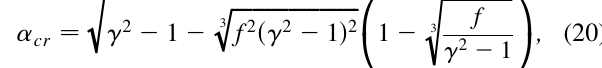
is met. At this point the bifurcation the condition f ¼ f cr resulting in the confluence of the center and the saddle takes place on the phase plane. As a result, the condition of adiabaticity is broken because the period of particles mo- tion (cid:3) in the vicinity of the separatrix tends to infinity. With the further increase in the wiggler field, when (cid:4) w becomes higher than the critical value given by (20), both the center and the saddle vanish and the phase plane becomes identical to that shown in Fig. 1(a). In this region of (cid:4) on the phase plane, the electrons move along the w trajectory embracing the area on the phase plane equal to that under the separatrix at the point of bifurcation. The motion of the electrons in real space becomes biperiodical with variable axial velocity and represents a combination of bounce oscillation and gyro-oscillation. 1 If the electrons possess cyclotron oscillations before they entered the wiggler (i.e. possess nonzero initial